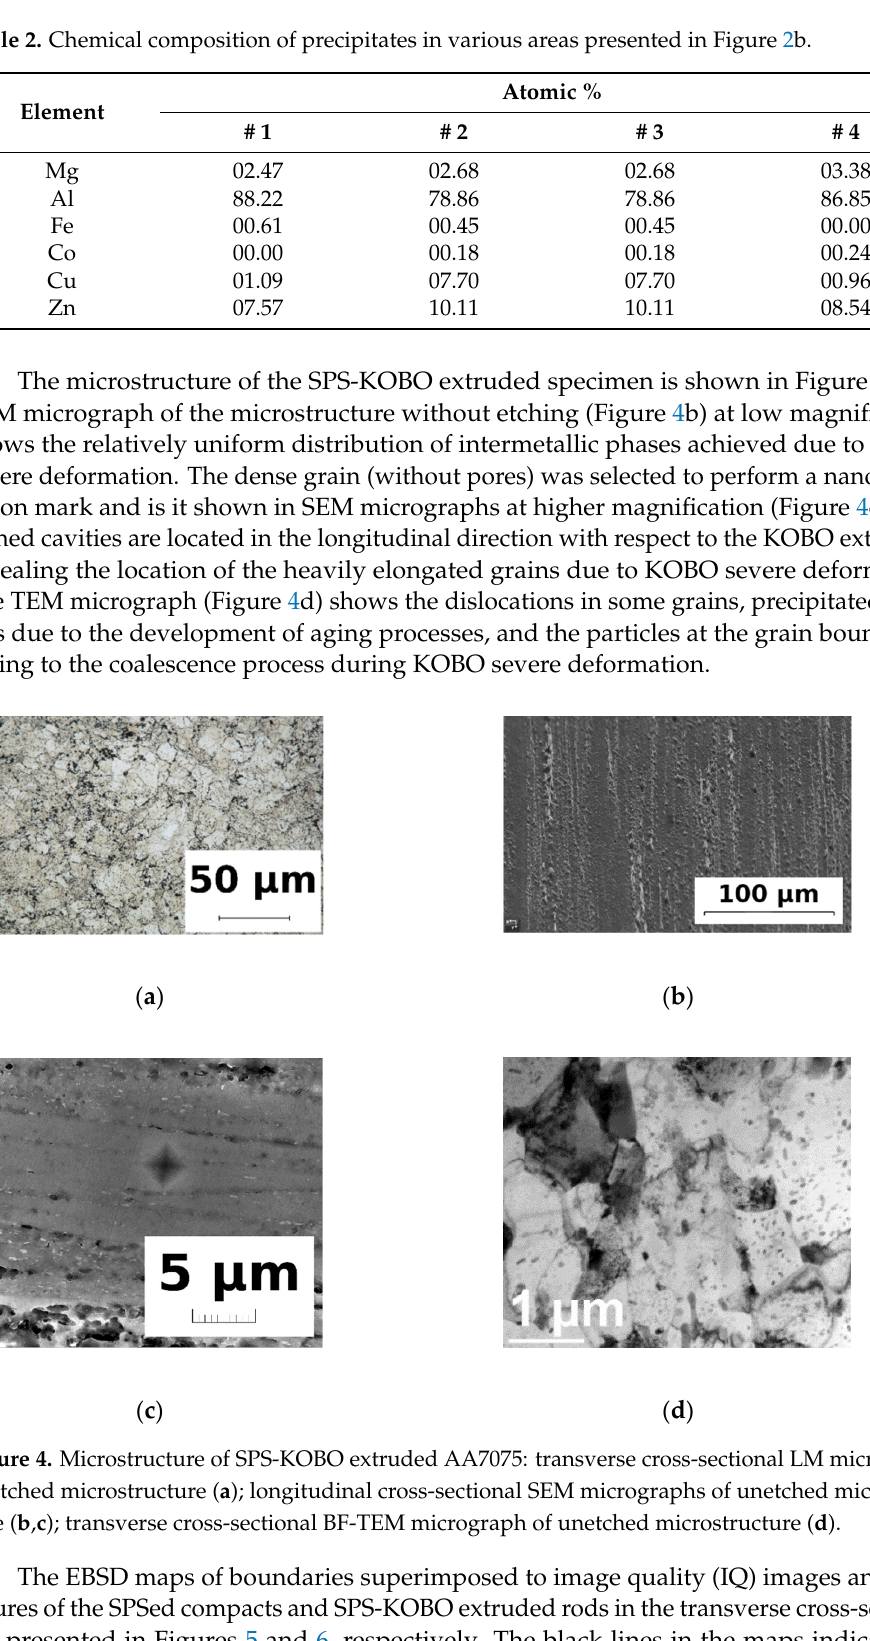
Table 2. Chemical composition of precipitates in various areas presented in Figure 2b.